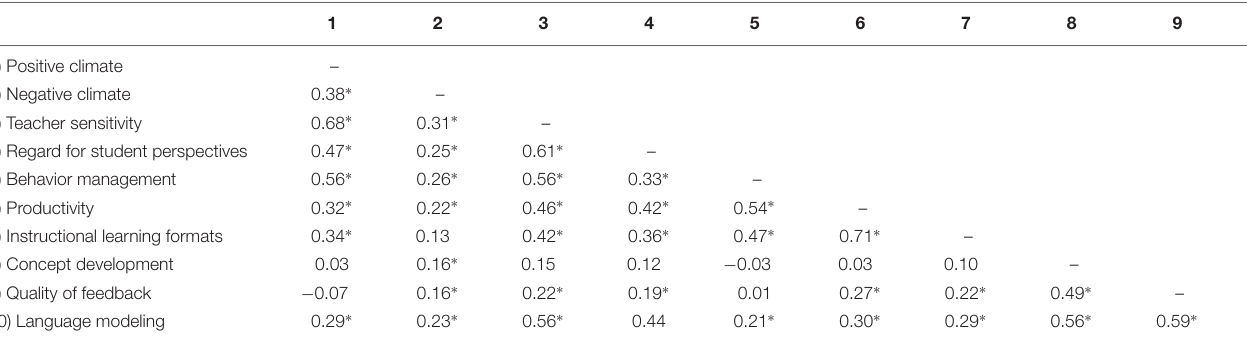
TABLE 2 | Correlations between the dimensions ( N = 177).